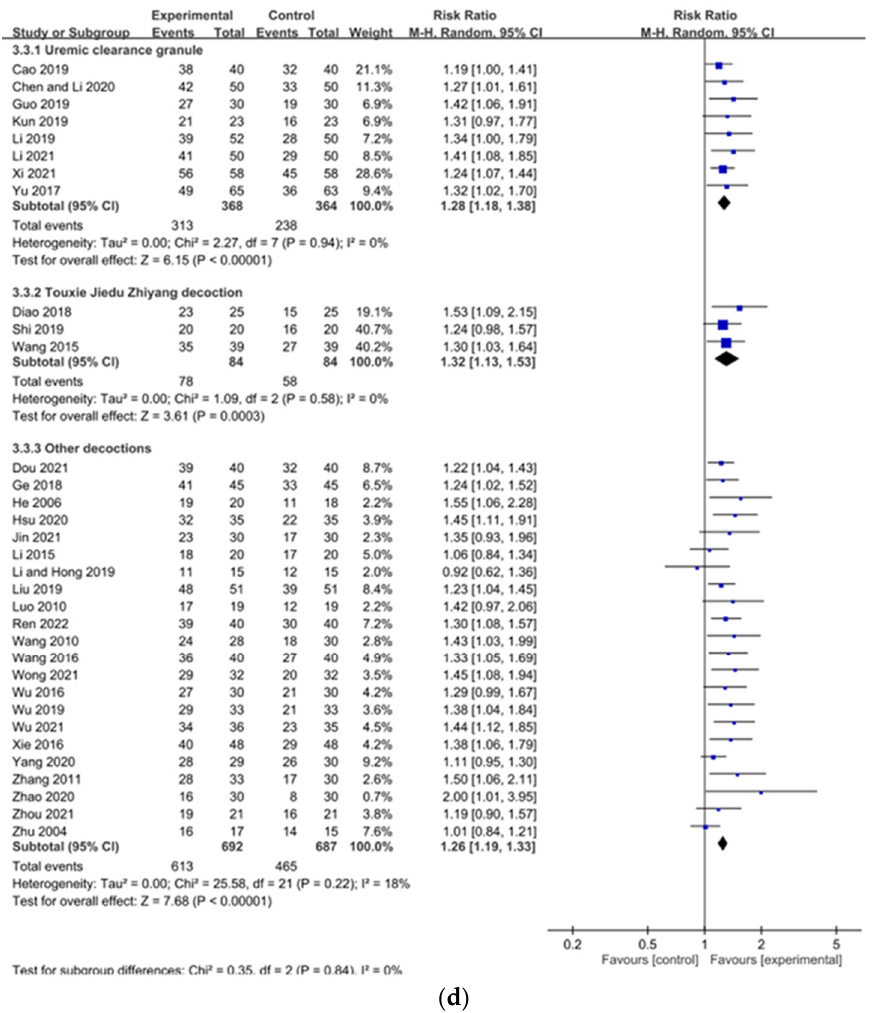
Figure 5. Forest plot of overall effectiveness of patients with uremic pruritus treated with Chinese herbal medicine (CHM): ( a ) overall effectiveness of included studies; ( b ) overall effectiveness of patients with uremic pruritus undergoing dialysis or not undergoing dialysis; ( c ) overall effectiveness of durations of CHM treatment in dialysis patients; ( d ) overall effectiveness of different Chinese herbal formulas.